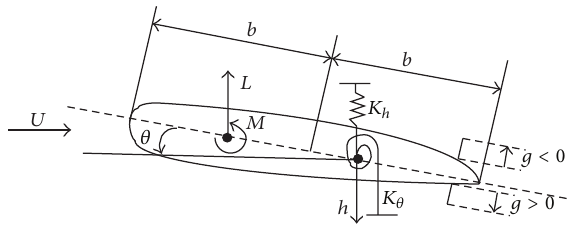
Figure 1: Typical two-dimensional blade